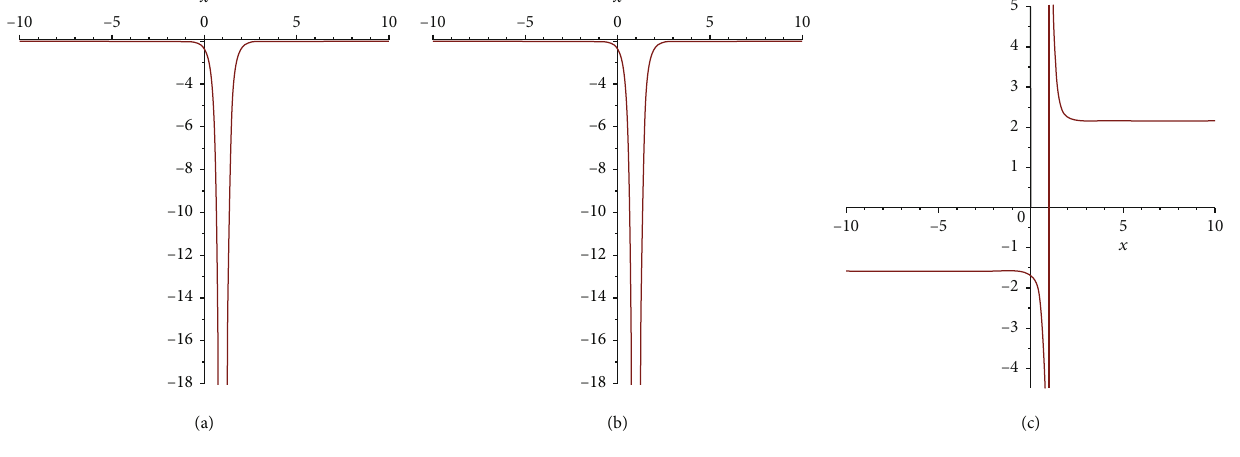
Figure 10: Plots of solution (28) for α = 0 : 5, b